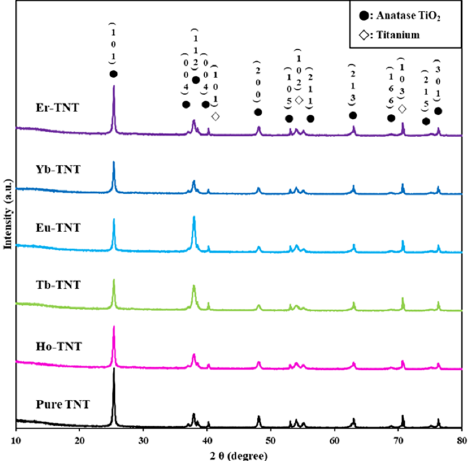
Figure 2. XRD patterns of pure TNT, Ho ‐ TNT, Tb ‐ TNT, Eu ‐ TNT, Yb ‐ TNT and Er ‐